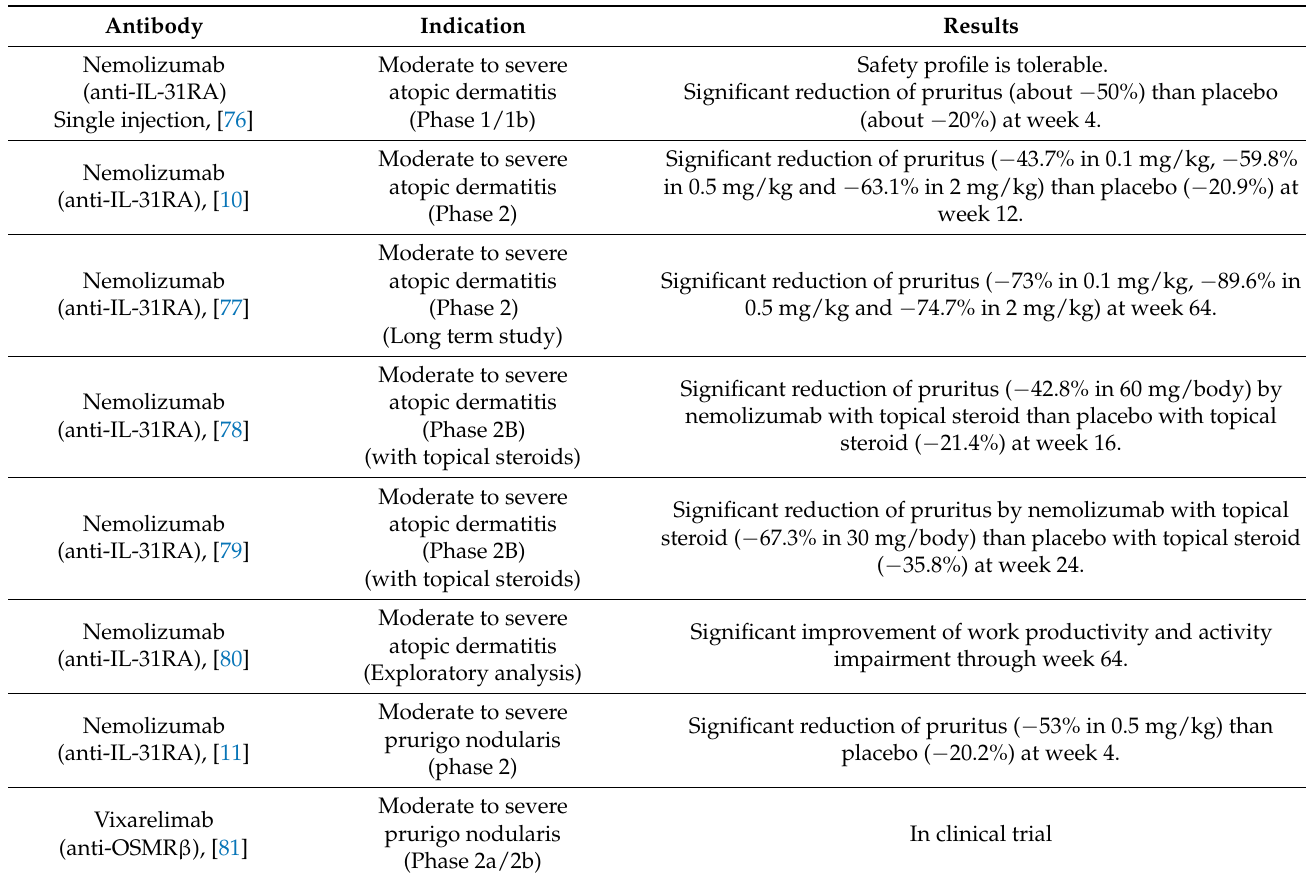
Table 2. Biologics targeting